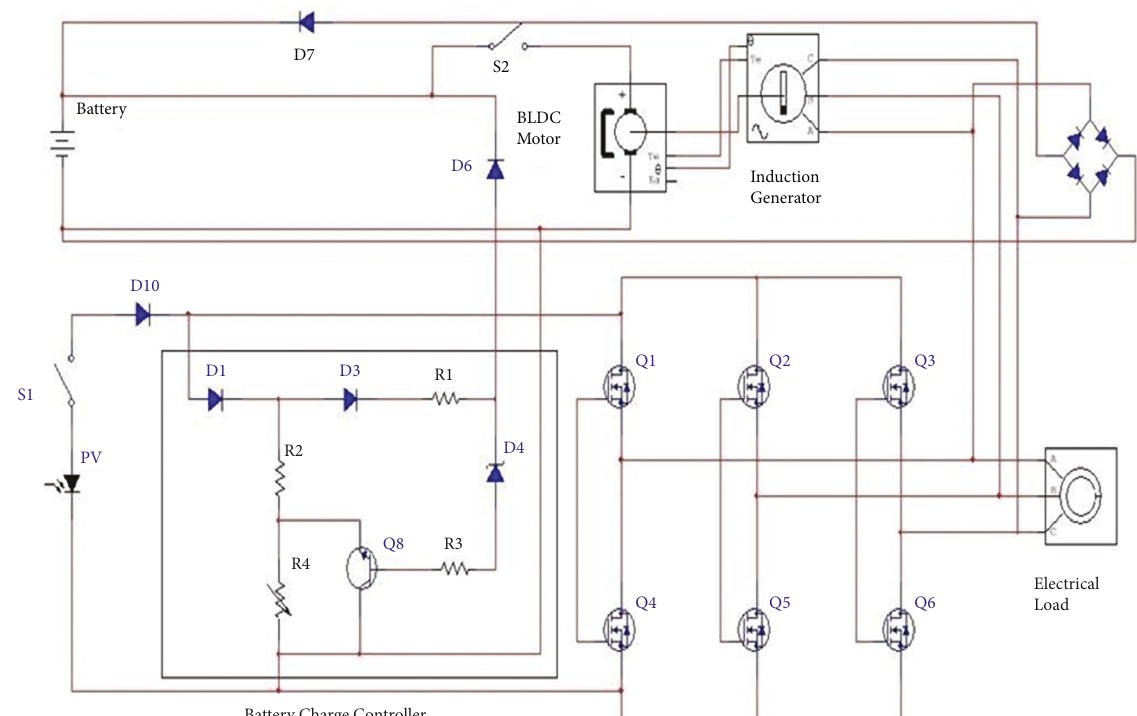
Figure 5: Equivalent circuit of the proposed